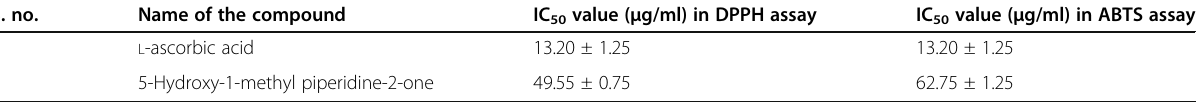
Table 1 IC 50 values for DPPH and ABTS radical scavenging activity of 5-HMP and L -ascorbic acid S. no.